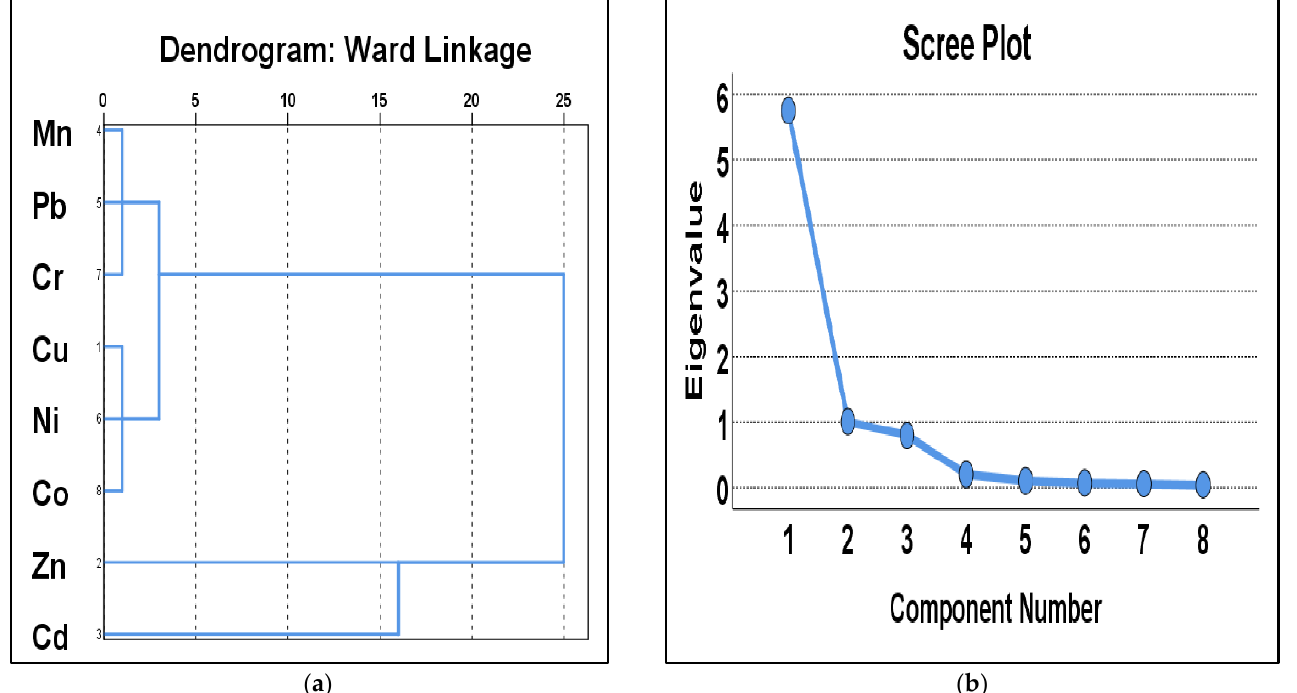
Figure 2. ( a ) Output of cluster analysis via dendrogram with Ward’s linkage; ( b ) output of principal component analysis via Scree plot, which shows the selected components (groups) that have values over ‘1’.